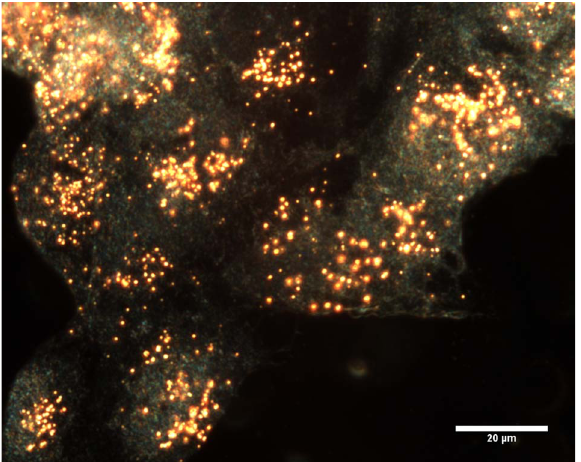
Figure 4. Dark field image at 60 6 magnification of BEAS-2B cells incubated with 1 nM AuNPs for 24 h.